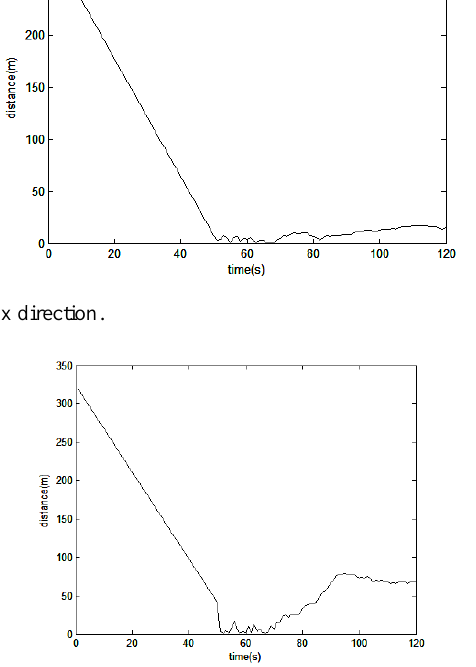
Fig. 5. RMS error in the y